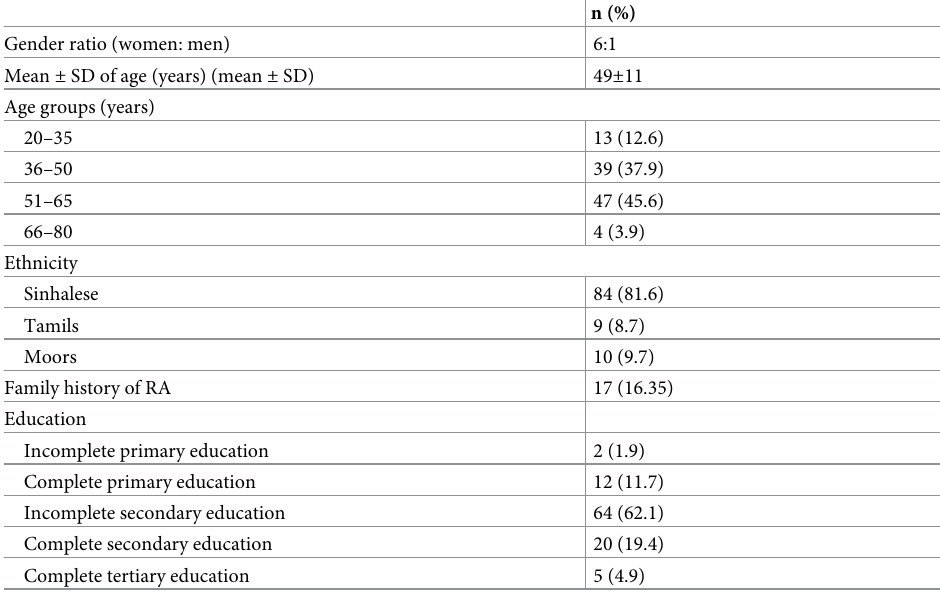
Table 1. Socio-demographic characteristics of the patient cohort (n = 103).